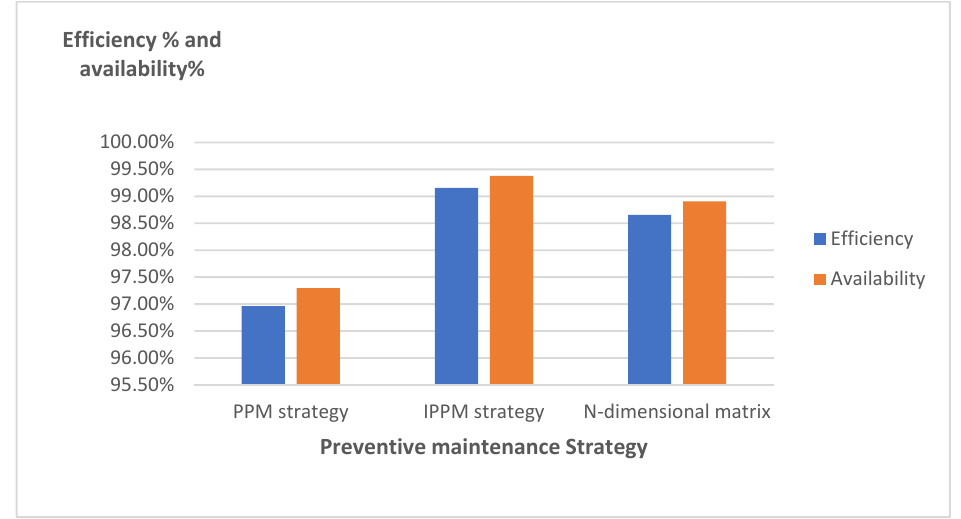
Figure 7. Comparison of mixed average values in applying the PPM strategy, the IPPM strategy and the n-dimensional matrix preventive maintenance proposal.